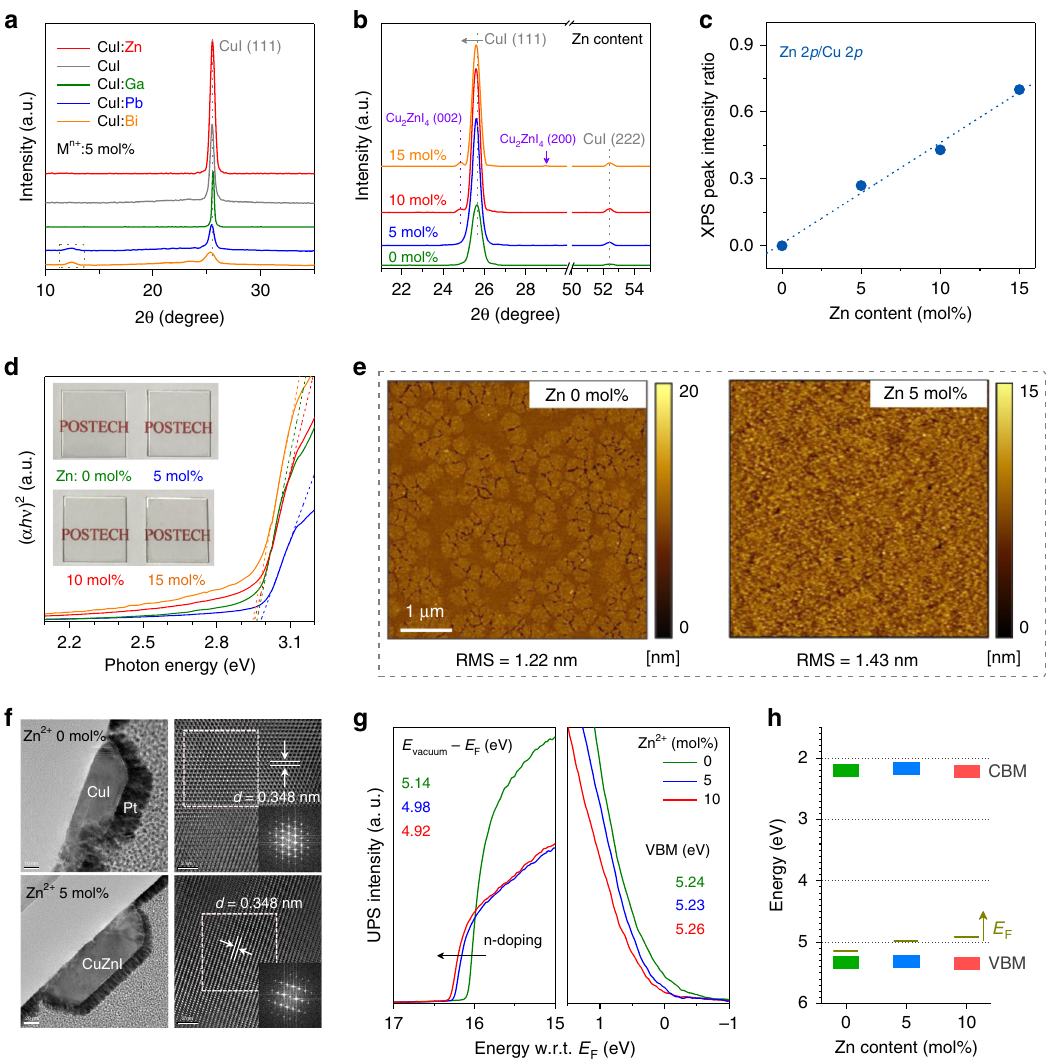
Fig. 2 Characterisations of the doped CuI thin fi lms. a XRD patterns of the CuI thin fi lms doped with different cations. b – d XRD patterns, XPS peak intensity ratios of Zn 2 p to Cu 2 p , and Tauc plots of the Zn-doped CuI fi lms with Zn doping contents of 0 – 15 mol%. e , f AFM and TEM images (FFT pattern) of the bare and 5-mol%-Zn-doped CuI fi lms (scale bar in HRTEM images is 2 nm). g , h UPS spectra of the secondary-electron onset and valence band regions and electronic energy level diagrams for the CuI:Zn thin fi lms with different Zn 2 + doping contents (0, 5, 10